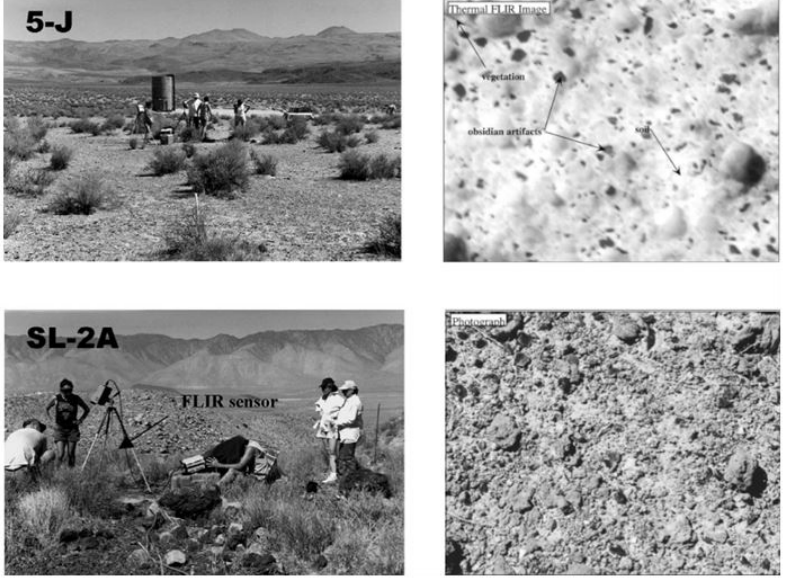
Figure 4. Use of a manual thermal camera for the analysis of different concentration of artifacts scattered on the ground as introduced by the authors in